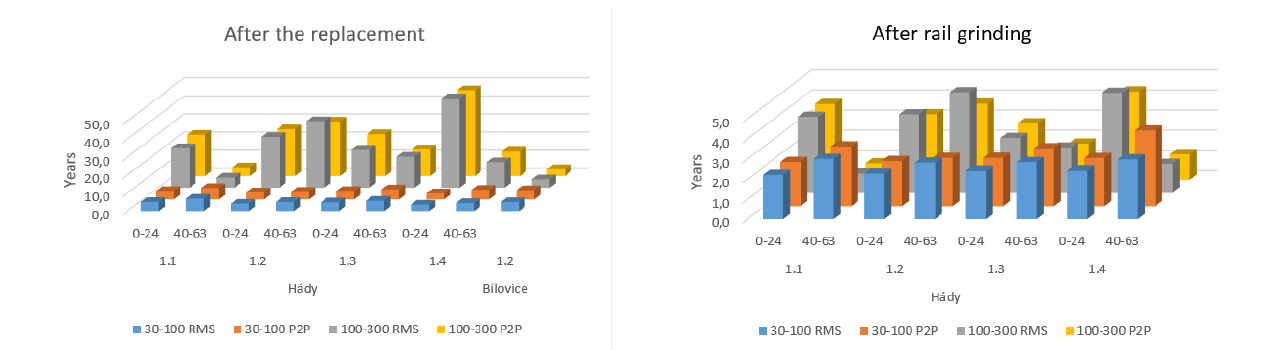
Figure 5. Number of years needed to reach the wave defect progression of the same level as before the rail